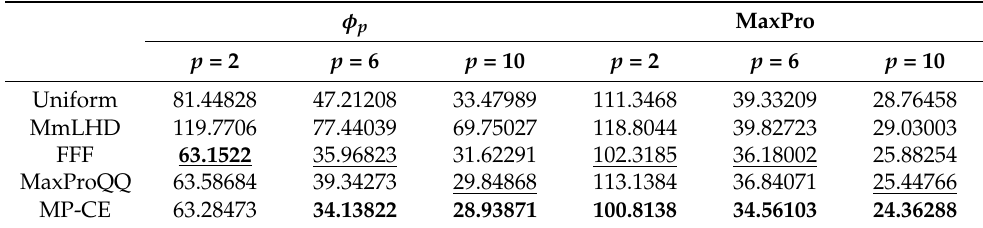
Table 1. Performance comparison of space-filling design methods.